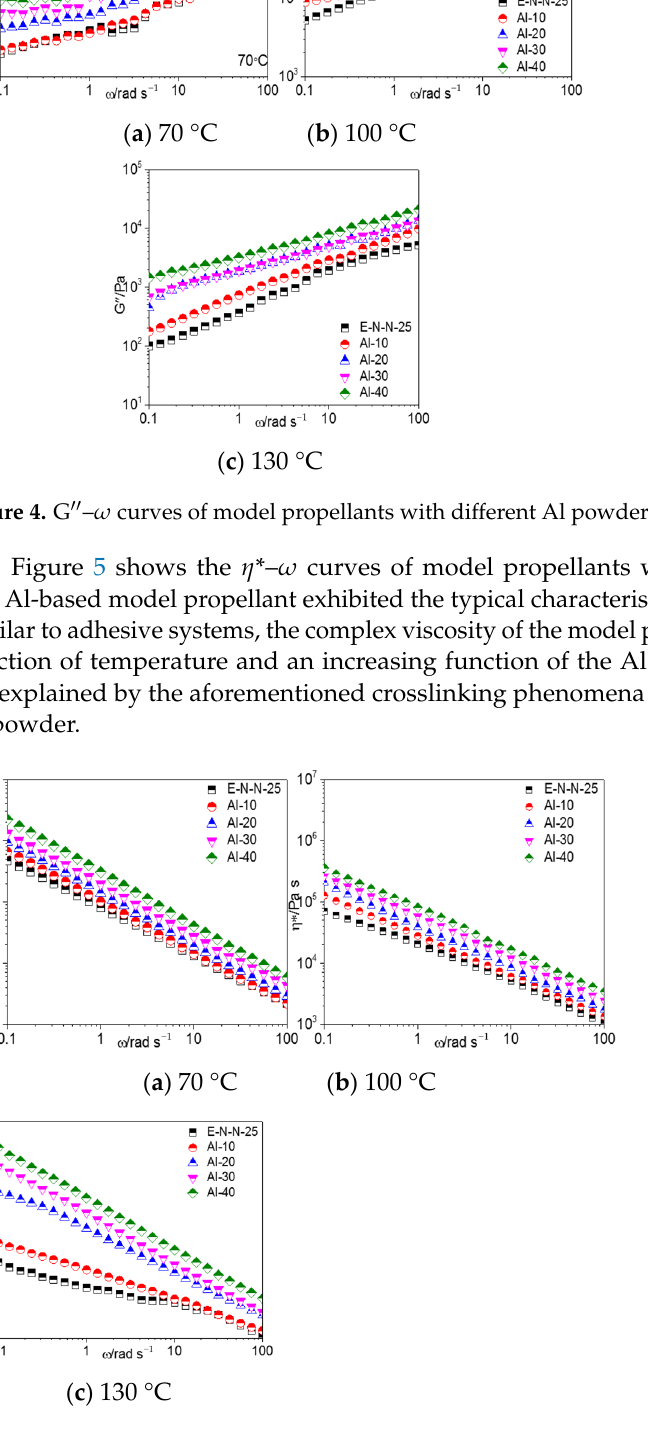
( b ) η *–T curve Figure 6. G ′ –T and η *–T curves of model propellants with different RDX contents ( γ = 1%, ω = 1 rad/s). In the first stage, G ′ and η * decreased slowly with the increasing temperature because the model propellant was elastic and the mobile units of the adhesive were small. In this stage, the molecular conformation of the adhesive could not change easily. The G ′ and η * declined faster in RDX-based model propellants than that in the Al-based model propel- lants for the following reasons. Firstly, Al powder has larger specific surface area com- pared with RDX particles, which could provide larger contact area with the adhesive. Sec- ondly, the wettability between Al powder and adhesive exceeded that of RDX, which re- sulted in a more fragile interaction between the RDX and adhesive. Therefore, the molec- ular interaction between Al powder and adhesive was significantly stronger than that of RDX. This is consistent with the changes in mechanical properties of the model propel- lants shown in Table S1 and Table S2 of the Supplementary Materials. The second and third stages were characterized by fast decreases in the G ′ and η *. In these stages, the physical crosslinking points in the adhesive were damaged, and the mo- lecular mobility was enhanced. As the number of mobile molecular units of the adhesive increased, the molecular conformation of adhesive was more easily altered, and G ′ and η * increased more rapidly with increasing temperature. However, the G ′ and η * of the pro- pellant were lower than those of adhesive when the temperature increased to 100 °C . This phenomenon could be explained by the weakening of the physical crosslinking effect be- tween the RDX and adhesive molecules at high temperatures and easy separation of RDX from the adhesive due to poor wettability. Moreover, at high temperatures, RDX can be